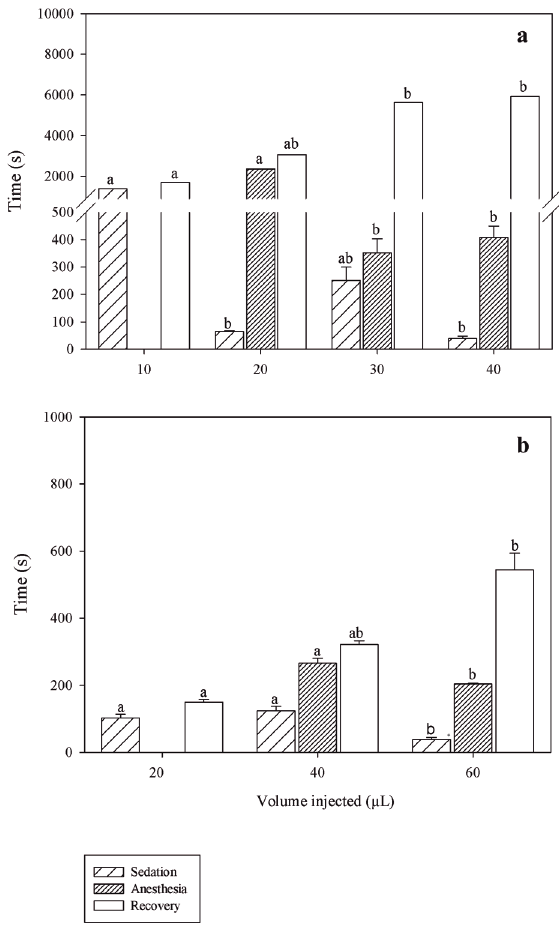
Figure 2 - Induction and recovery times of terpinen-4-ol ( a ) and nanoencapsulated TTO ( b ) injected in Neohelice granulata . Stages of induction were observed according to Gardner (1997) and Morgan et al. (2011). Maximum observation time for induction and recovery was 30 min. Data are presented as mean ± SEM ( n = 5). Different letters indicate significant differences between concentrations, for the same stage ( p <